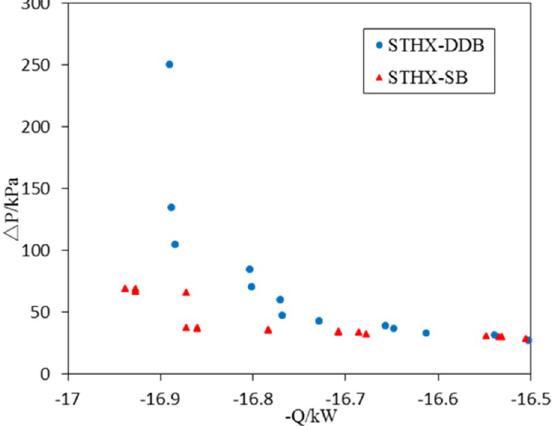
Figure 17. Pareto optimal points for the heat transfer capacity range of 16.5–17 kW.